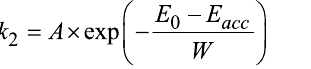
Table 1: Approximate kinetic energy of an ideal impact of a 1.43 g milling ball at different milling frequencies. The relative frequency is shown in each case. Note that the milling jar oscillation distance was measured at 4